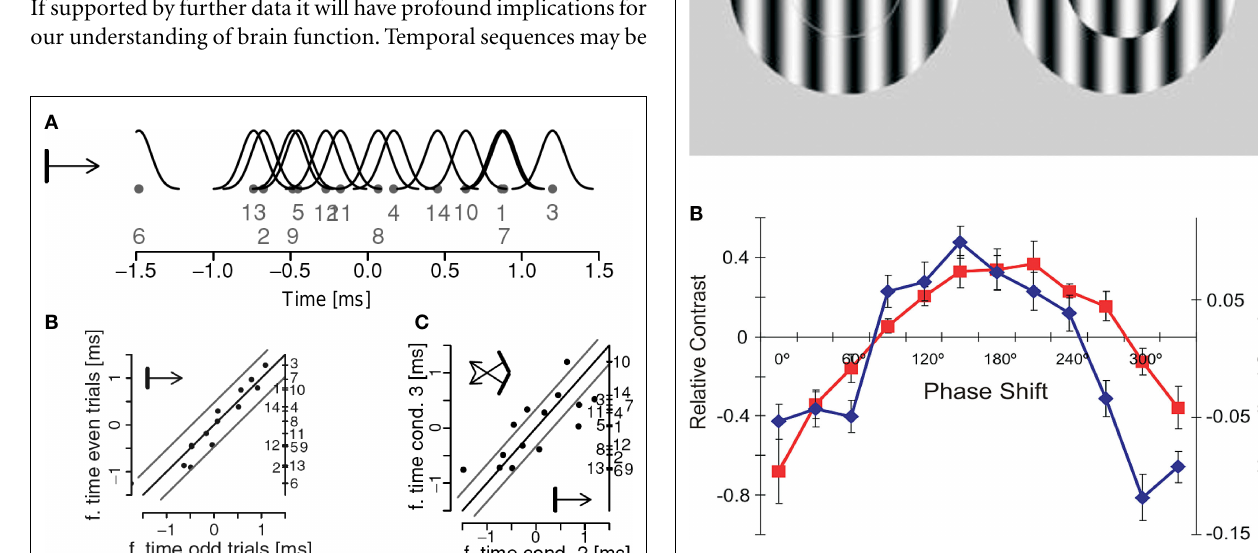
FIGURE 3 | (A) A fi ring sequence extracted for a network of 14 units. The dots denote the estimated positions of the units, the number their identities, and the black curves indicate the localization errors. (B) The relative fi ring sequence in (A) estimated for two repetitions of the same stimuli. Gray lines parallel to the diagonal indicate error limits of two standard deviations. Unit identities are indicated on the right side of the panel. (C) Changes in fi ring sequences as a function of a change in stimulus properties. Stimuli are sketched in the corners of the graph. Units outside the error lines change signifi cantly their preferred fi ring times. Adapted from Schneider et al. (2006).